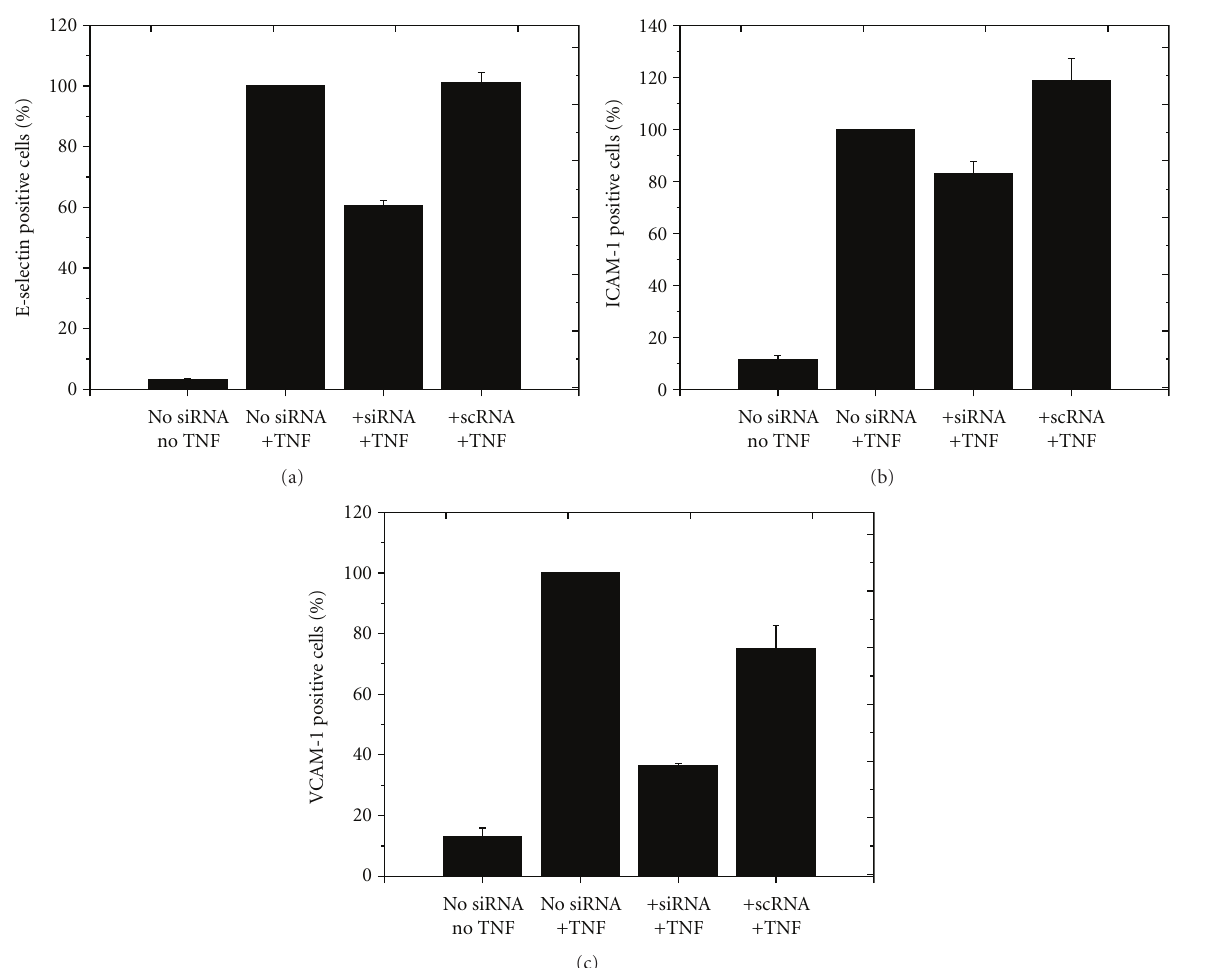
Figure 3: Application of the mixture of 3 di ff erent siRNAs targeting ESELE, ICAM-1, and VCAM-1 demonstrated the practicability and e ffi cacy of transfection of multiple siRNAs simultaneously. The y -axis reflects the respective adhesion receptor expression (in %), whereby untreated cells stimulated with TNF- α (group 2) were set to 100%. x -axis: group 1: HLMECs without siRNA transfection and without TNF- α stimulation; group 2: HLMECs without siRNA transfection, but with TNF- α stimulation; group 3: HLMECs transfected with 3 di ff erent receptor specific siRNAs and with TNF- α stimulation; group 4: HLMECs transfected with a nonspecific siRNA and with TNF- α stimulation. Each bar represents the mean ± SD of n = 3 independent